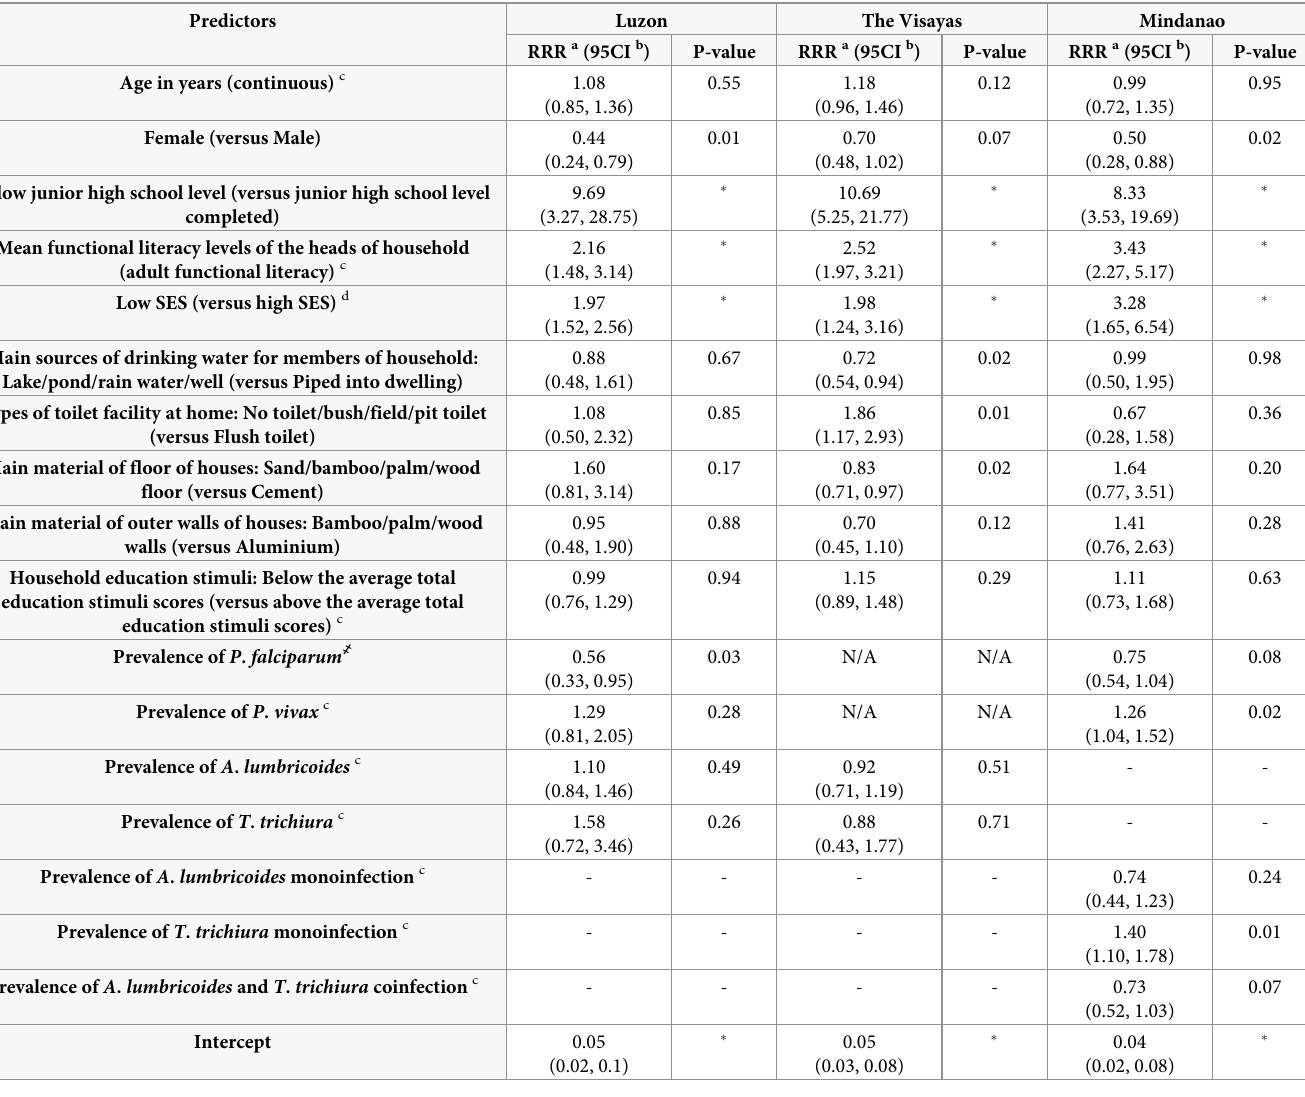
Table 6. List of predictors considered as influencing the prevalence of functional illiteracy in school-aged children.